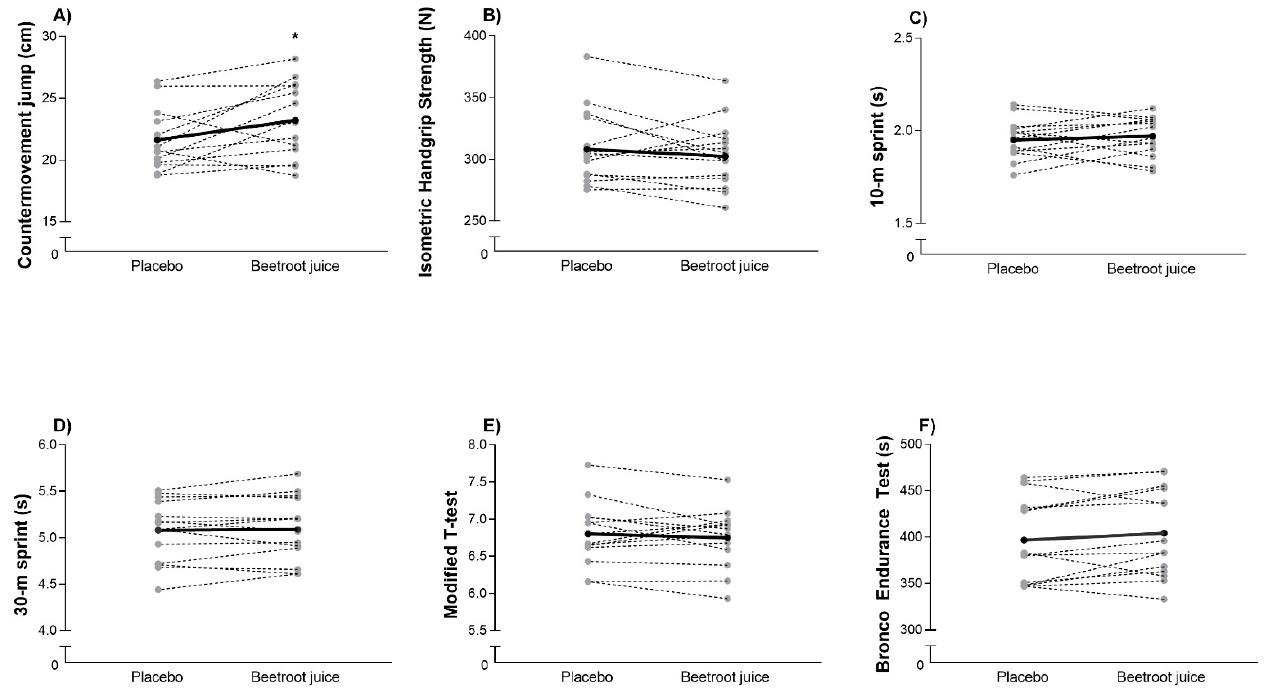
Figure 1. Height during a countermovement jump ( A ), Dominant isometric handgrip strength ( B ), Time during a 10-m sprint test ( C ) and during a 30-m sprint test ( D ), Time for completing agility t -test ( E ) and time to complete Bronco endurance test ( F ) after beetroot juice or placebo ingestion in semi-professional female rugby players. Means are represented by a horizontal black bar and each individual is represented by a discontinuous grey line. * Statistical differences were set at p <